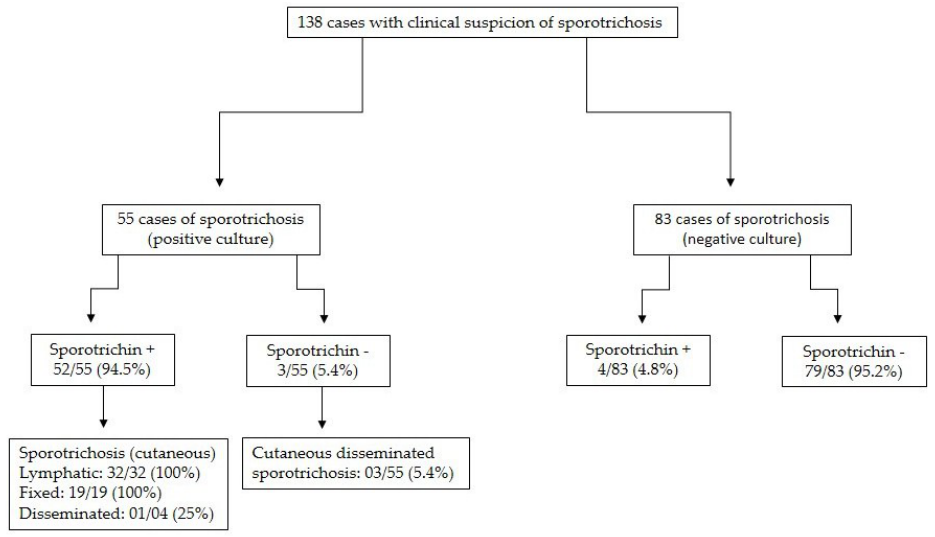
Figure 2. Flowchart of the cases studied. + means positive, and − means negative.